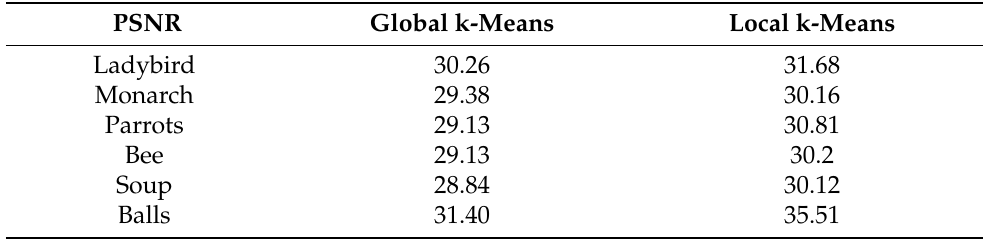
Table 1. Image segmentation quality for global (original) and local (proposed) use of the k-Means algorithm in the means of